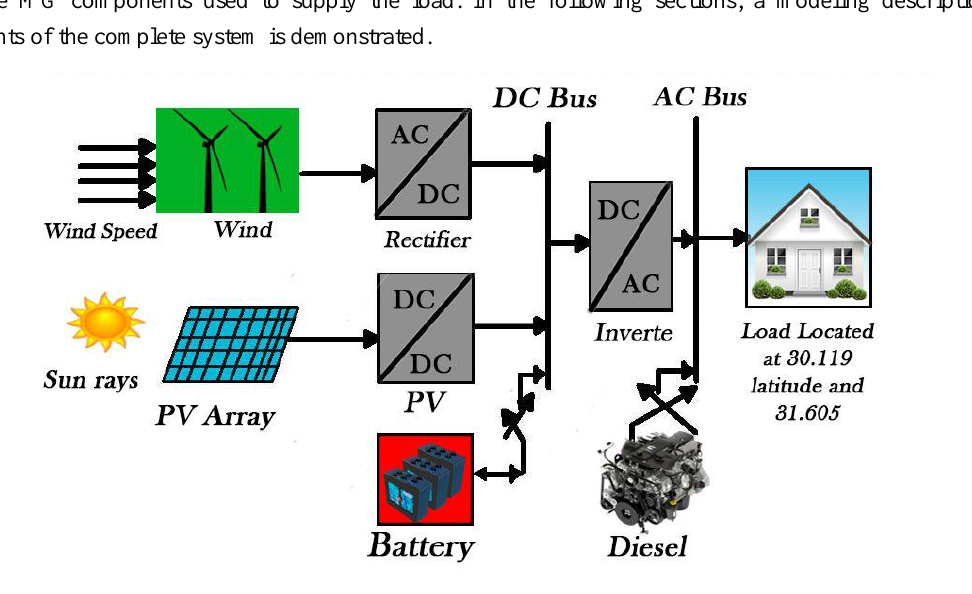
Figure 1. Schematic diagram for the proposed hybrid multi source MG